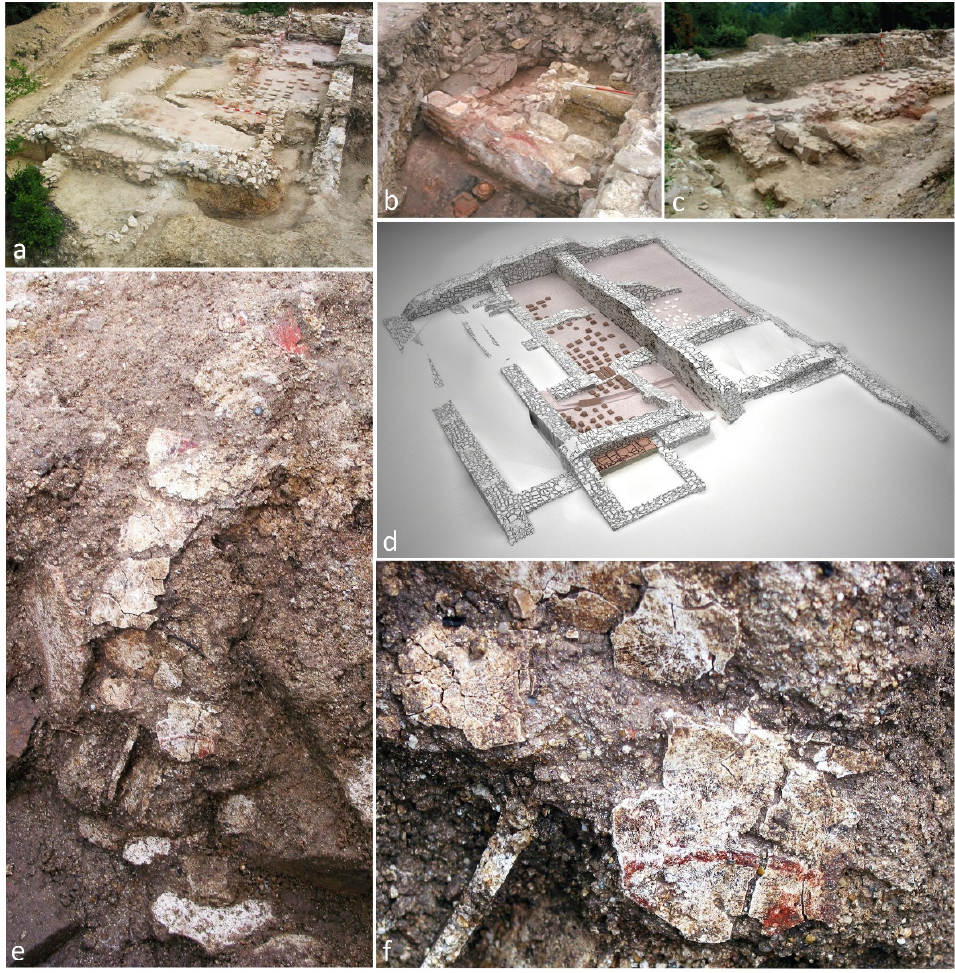
Figure 1. Details showing the ruins of the bathhouse discovered at Alburnus Maior ( a – c ); 3D model of the bathhouse ( d ); wall painting fragments found in situ ( e , f ). Images reprinted with permission from [5].